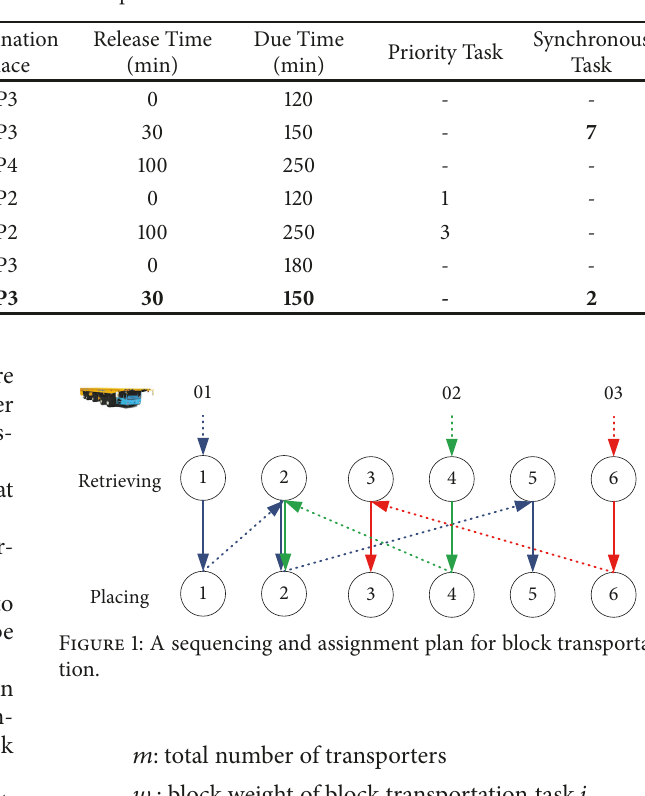
Table 2: Preprocessed block transportation tasks.